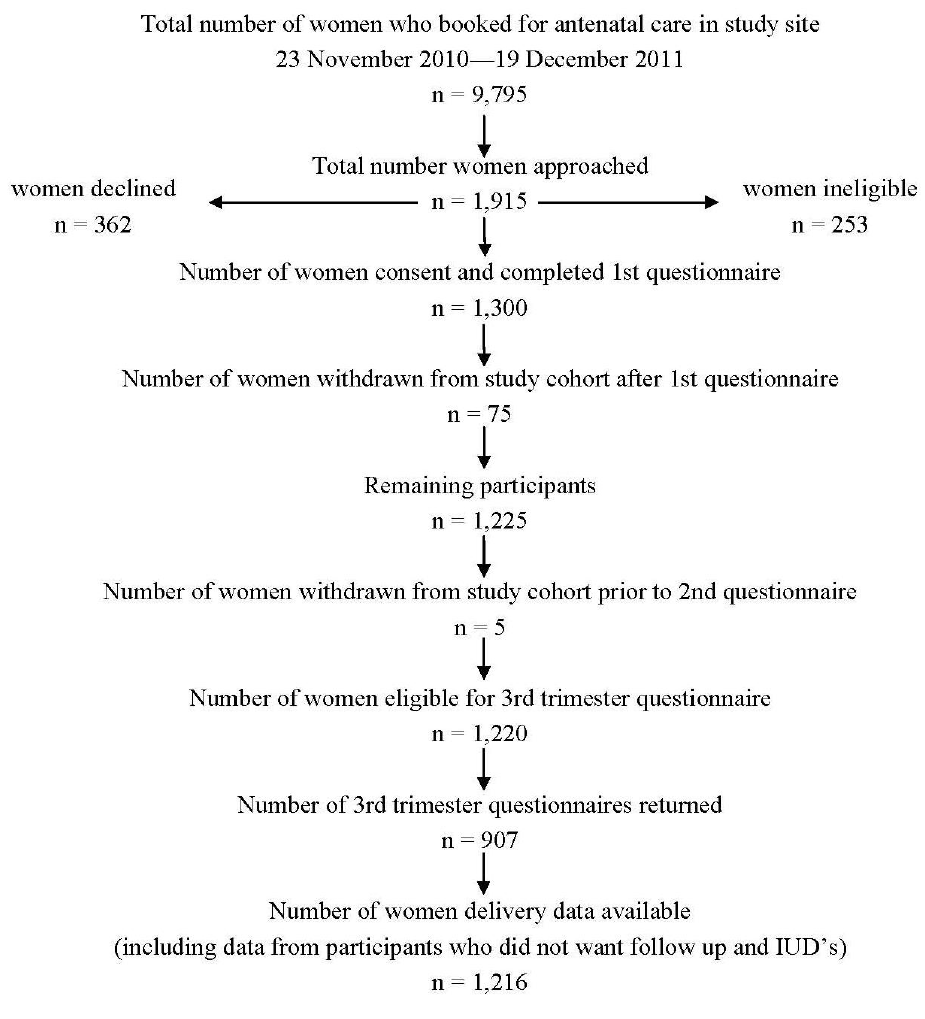
Figure 1. Cohort flow